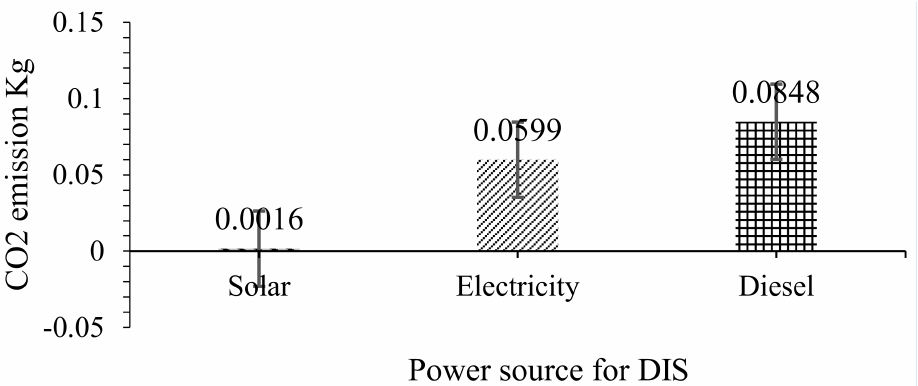
Figure 12. CO 2 emission kg/kg of maize production with different power sources for